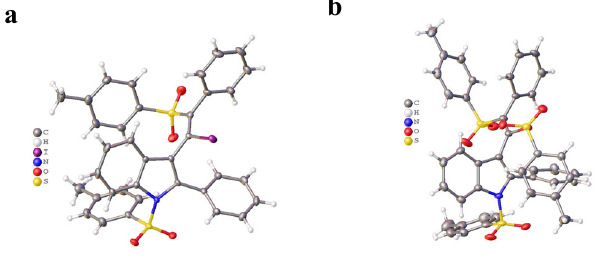
Fig. 2 Crystal structures of E isomers. a Crystal structure of 3 . b Crystal structure of